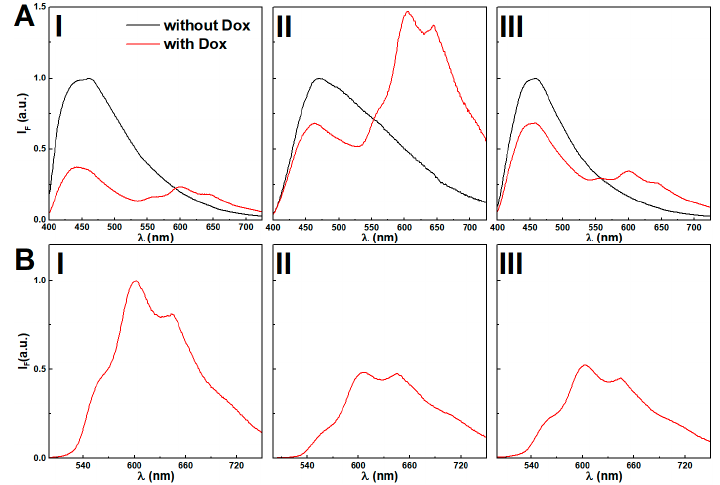
Figure 8. ( A ) Fluorescence emission spectra ( λ exc = 375 nm) of hydrogel (I) and magnetogels containing citrate-stabilized (II) and lipid-coated (III) manganese ferrite nanoparticles (0.025 wt%) incorporating the doxorubicin and comparison with the plain gels. ( B ) Fluorescence spectra ( λ exc = 480 nm) of directly-excited doxorubicin in gels, (I) and magnetogels con-taining citrate-stabilized (II) and lipid-coated (III) manganese ferrite nanoparticles (0.025 wt%) incorporating the doxorubicin and comparison with the plain gels